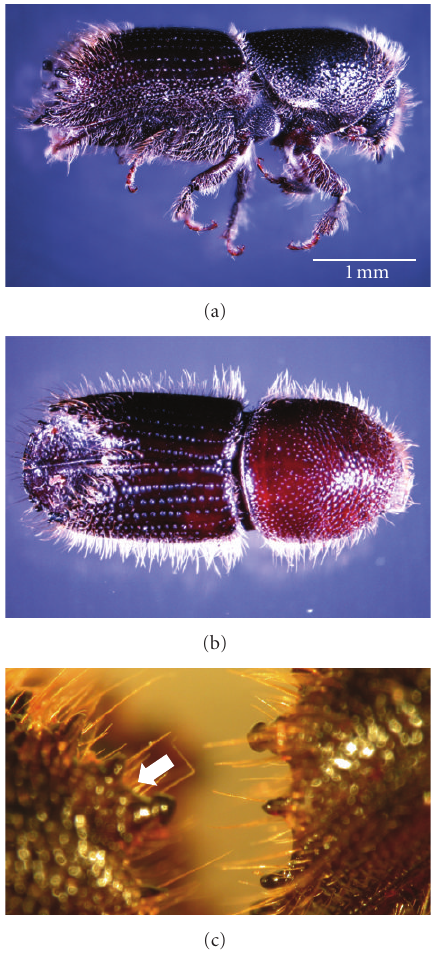
Figure 1: Ips sexdentatus (B¨orner) (Coleoptera: Curculionidae: Scolytinae), lateral (a) and dorsal views (b), and detail of the elytral declivity of male (left) and female (right). Note the fusion at the base of the 3rd and 4th teeth in male (white arrow).